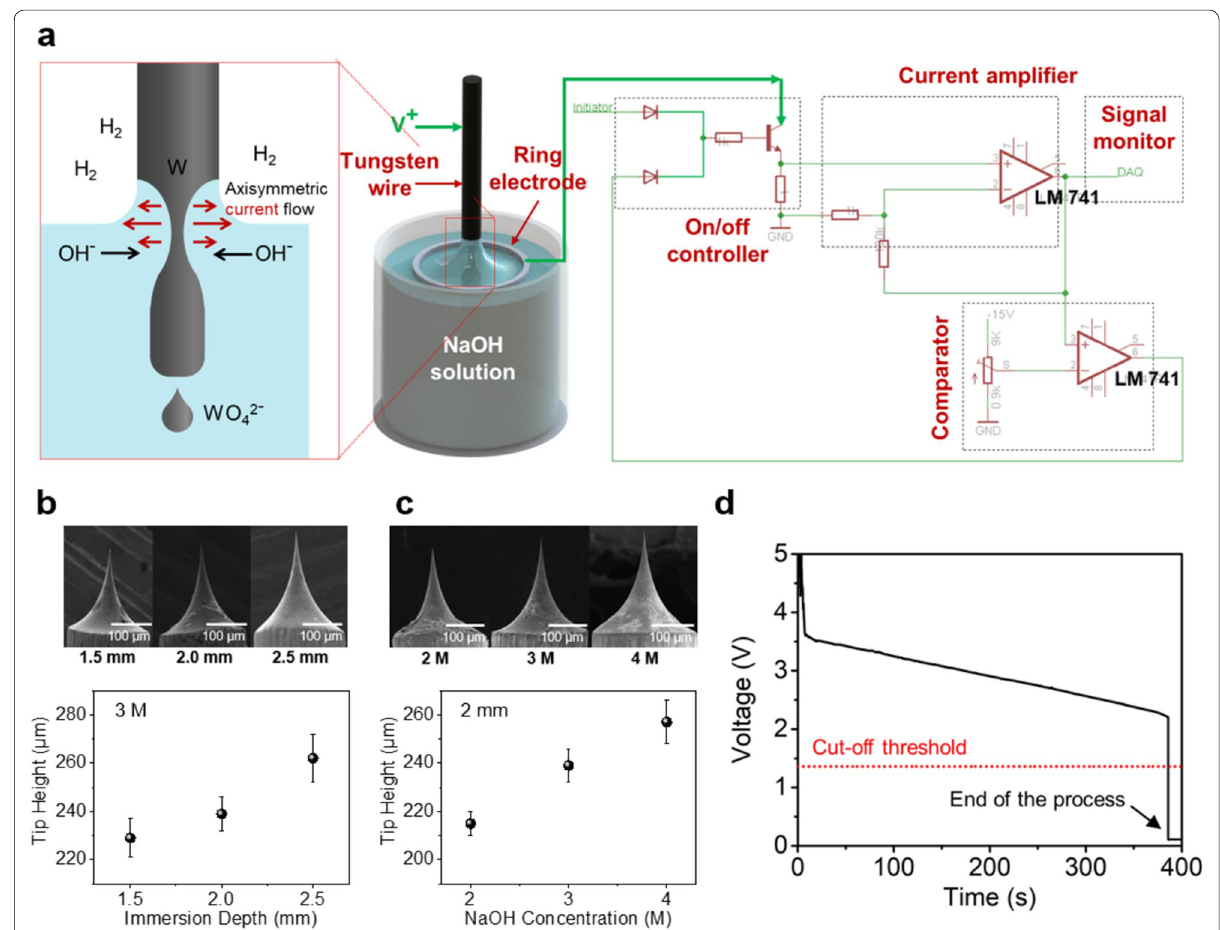
Fig. 1 Time controlled electrochemical etching of tungsten wire in sodium hydroxide (NaOH) solution. a Schematic for the electrochemical etching along with the feedback circuit composed of a high-speed voltage comparator. b Tip height as a function of the immersion depth and corresponding SEM images. c Tip height as a function of the NaOH concentration and corresponding SEM images. d Typical time-dependent voltage change monitored during the electrochemical